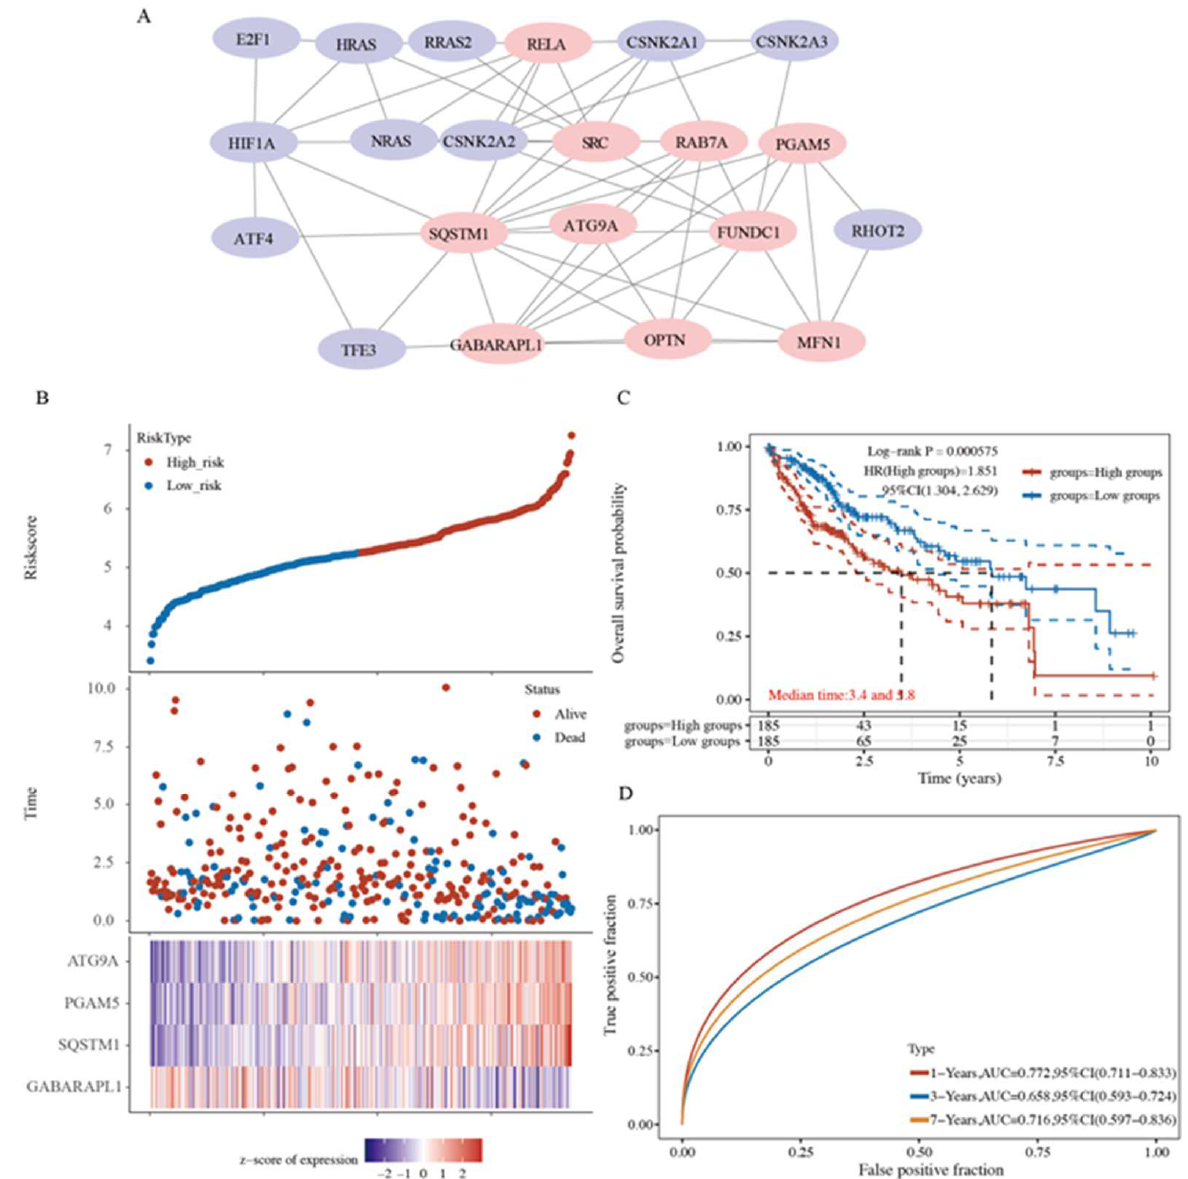
Figure 6. Mitophagy-related prognostic model construction was established for prognosis prediction. ( A ) Top 10 genes were optimized by protein–protein interaction (PPI) networks. ( B ) The risk